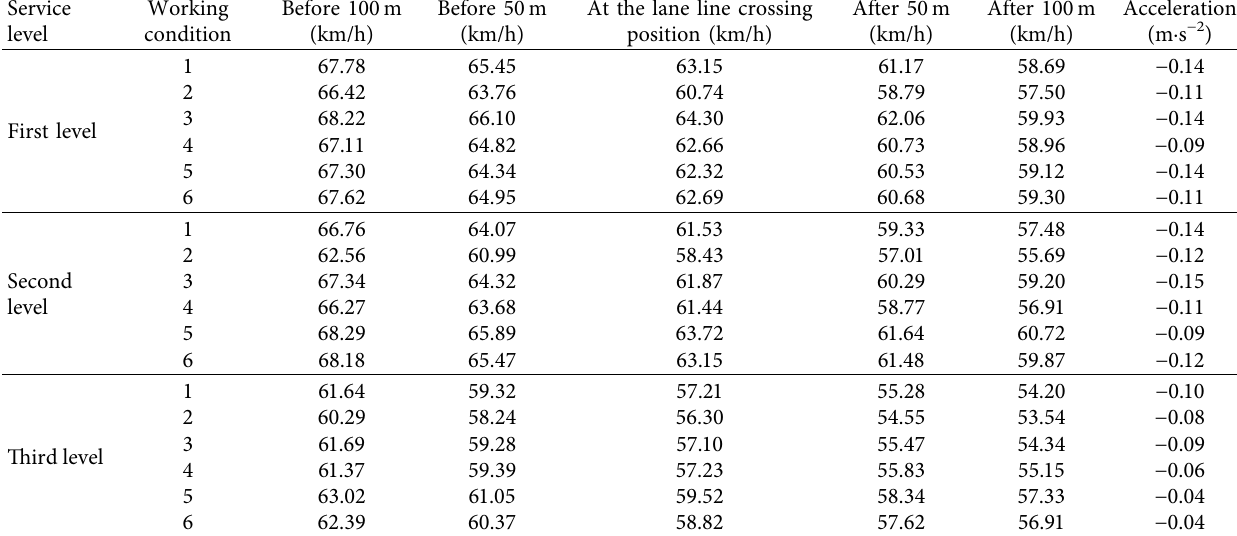
Figure 12: Vehicle speed and acceleration curves within 200m before and after the lane change position in the third service level. (a) Speed curve. (b) Acceleration curve. Table 5: Vehicle speed and acceleration within 100 m before and after the lane change position.